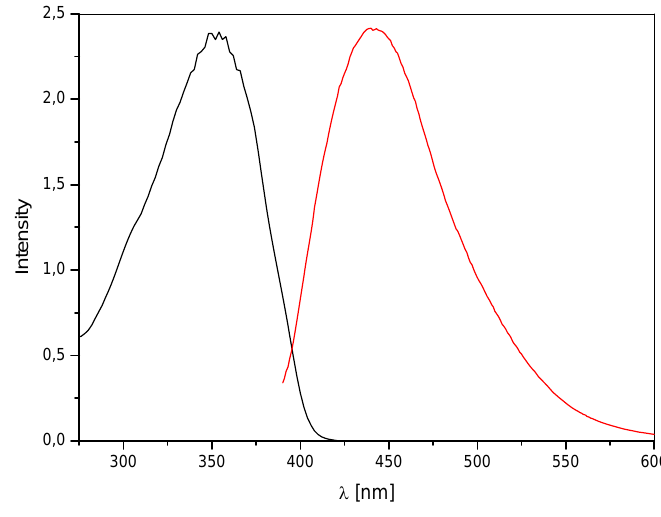
Figure 2. Absorption ( ⎯⎯ ) and fluorescence emission ( λ in methanol.